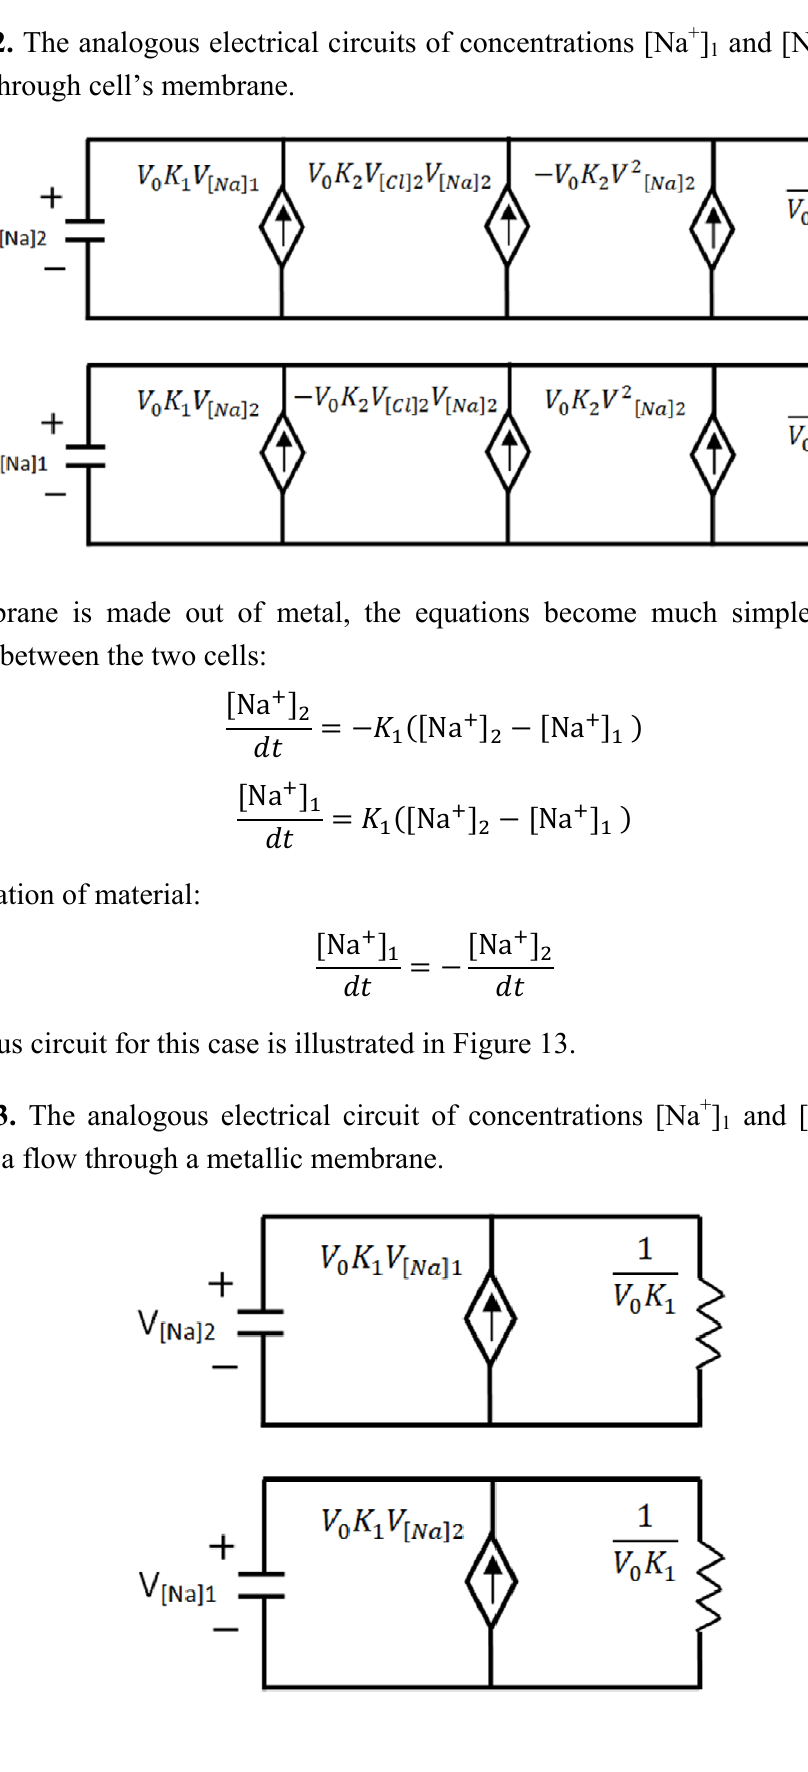
and [Na + ] related to 1 2